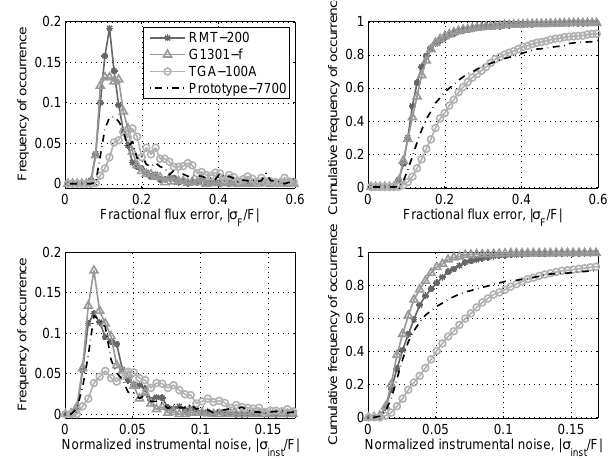
Fig. 5. Top row: Distribution curves of absolute value of fractional flux error ( | σ F /F | ) (left plot) and cumulative sums of relative fre- quency of occurrence (right plot). Bottom row: the same as the top row, but for normalized instrumental noise ( | σ inst /F | ). Frequency of occurrence is normalized with the amount of measurements and, thus the curves on the left give relative amount of data in each bin. Only periods when all the methane gas analyzers were working were